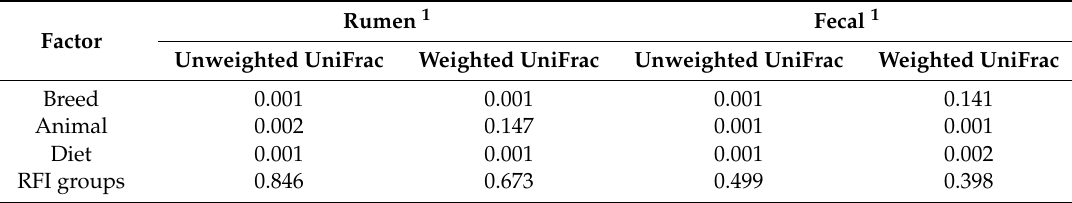
Figure 3. PCoA analysis on UniFrac distances of the microbial communities in rumen (top) and feces (bottom) per breed (Holstein and Jersey) and diet (high-concentrate: HC; and low-concentrate: LC). Left panels are weighted and right panels are unweighted UniFrac distances. Values in parenthesis give the amount of variation explained by each coordinate. Table 1. Effect of breed, animal, diet, and residual feed intake (RFI) group on the beta diversity of bacteria in rumen and feces.